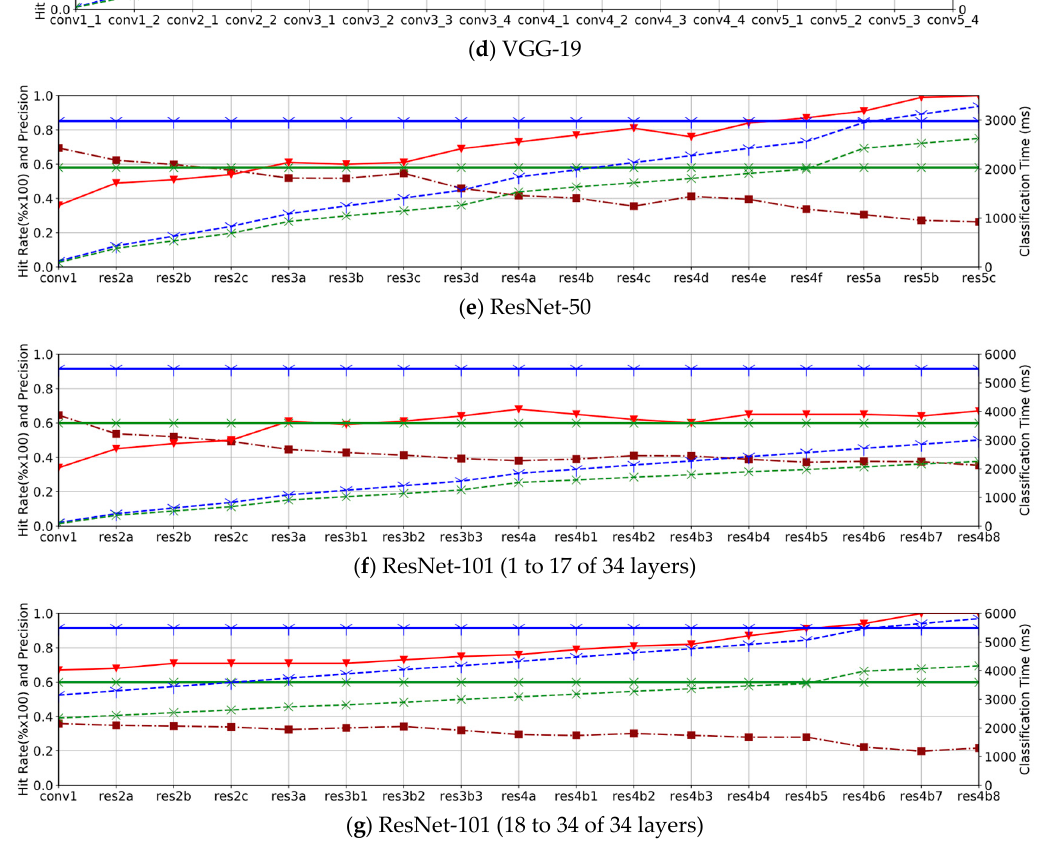
Figure 7. Comparison of classification times required by the CNN and cache according to layer.